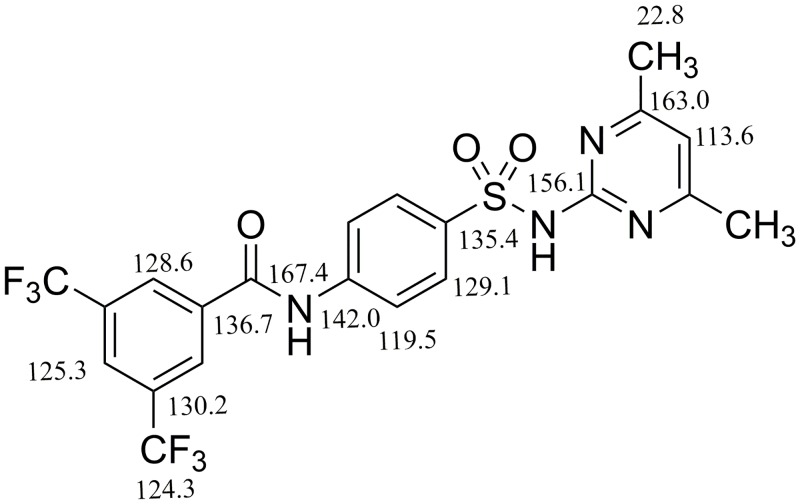
13C-NMR chemical shifts of compound 6.